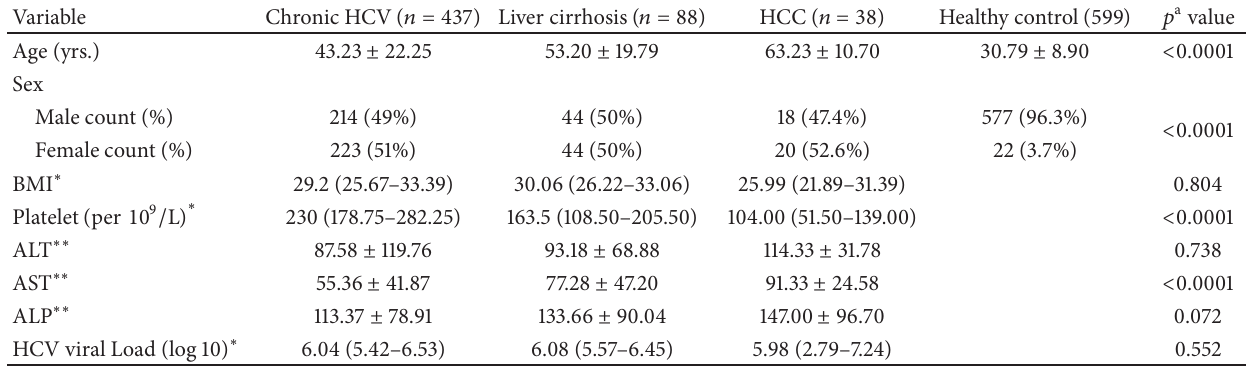
Table 1: Baseline and clinical characteristics of HCV-infected patients and healthy control subjects.